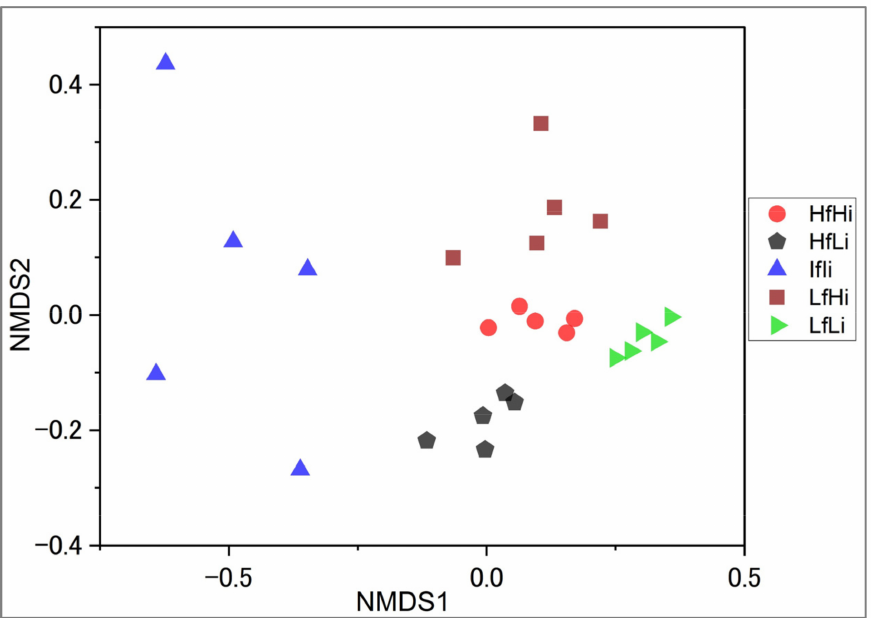
Figure 4. Non-metric multidimensional scaling (NMDS) based on species composition for the fire regime strata, using the Bray–Curtis index.